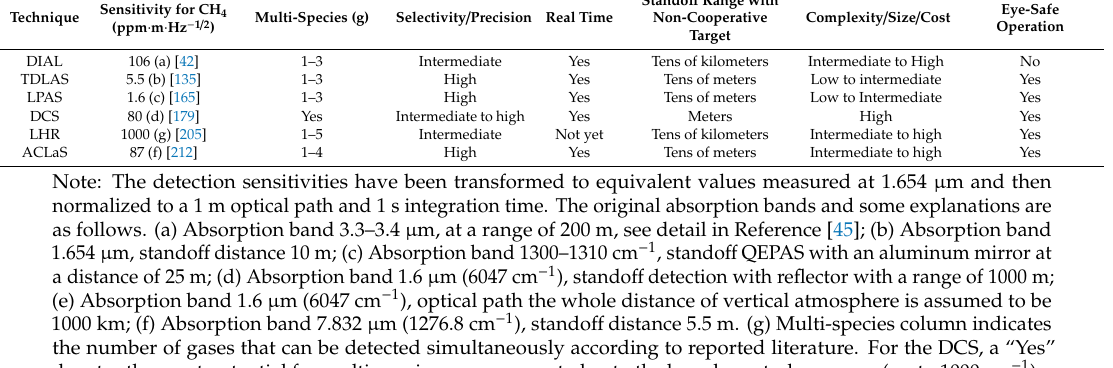
Table 8. Performance comparison of LAS-based stando ff detection techniques. Technique SensitivityforCH 4 (ppm · m · Hz − 1 / 2